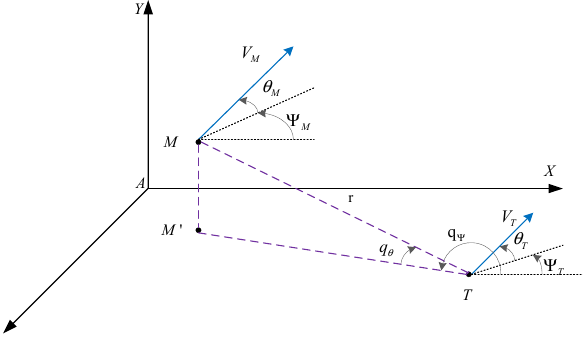
Figure 1. Guidance geometric relationship.